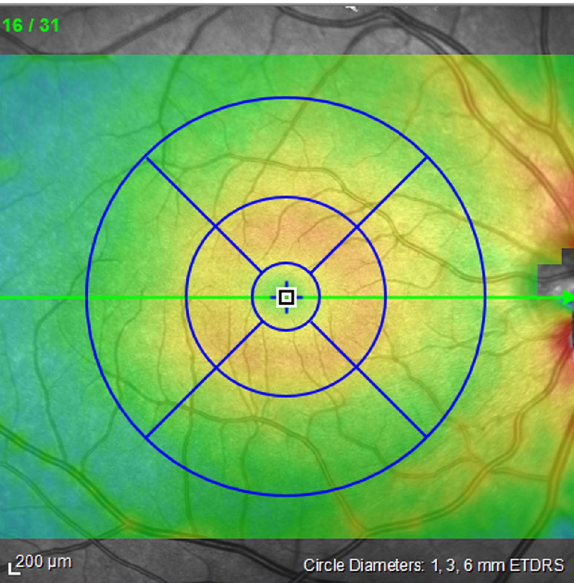
Figure 5. Macular regions measured: central (0.5-mm radius around the fovea), inner ring (region between 0.5- and 1.5-mm radius around the fovea), and outer ring (region between 0.5- and 3.0-mm radius around the fovea) at the superior, inferior, temporal, and nasal